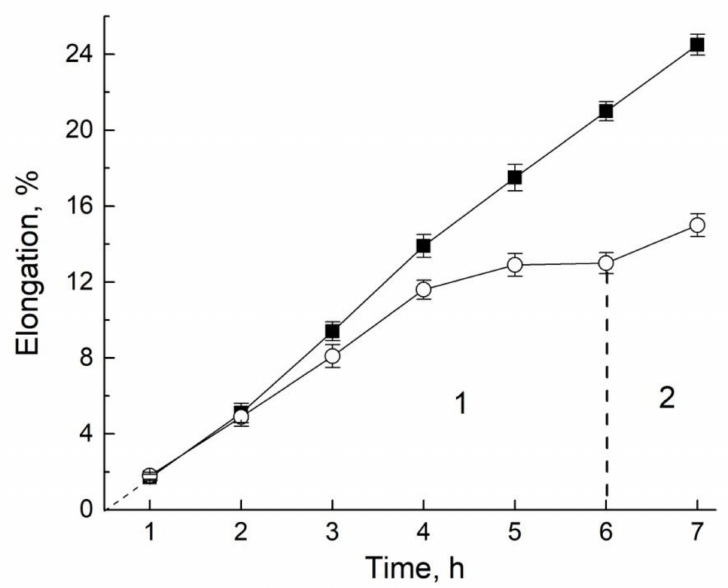
Figure 19. Time course of elongation (in percent) of the intact roots at 23 ◦ C under the atmosphere pressure (solid squares) and under the impact of external air pressure of 2 MPa (open circles). After 6h of 2 MPa pressure impact (region 1) the pressure was released to the level of atmosphere (region 2)